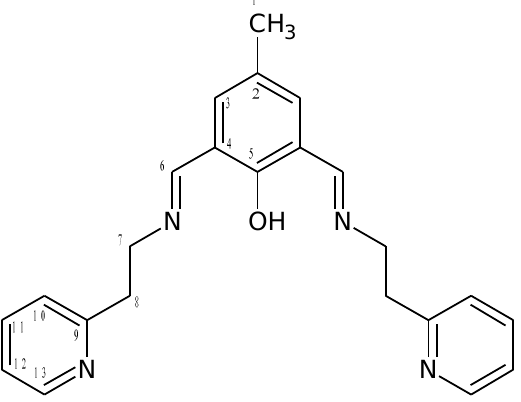
Figure 16. Structural formula and atomic numbering scheme for HL2.